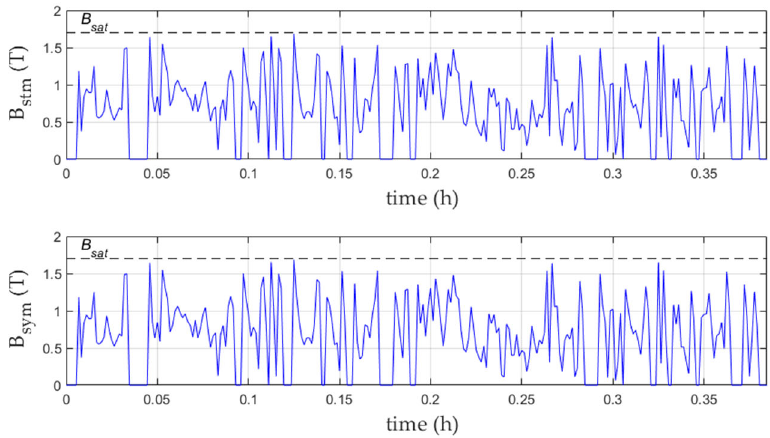
Figure 10. Maximum flux densities versus time in the stator yoke and stator teeth.